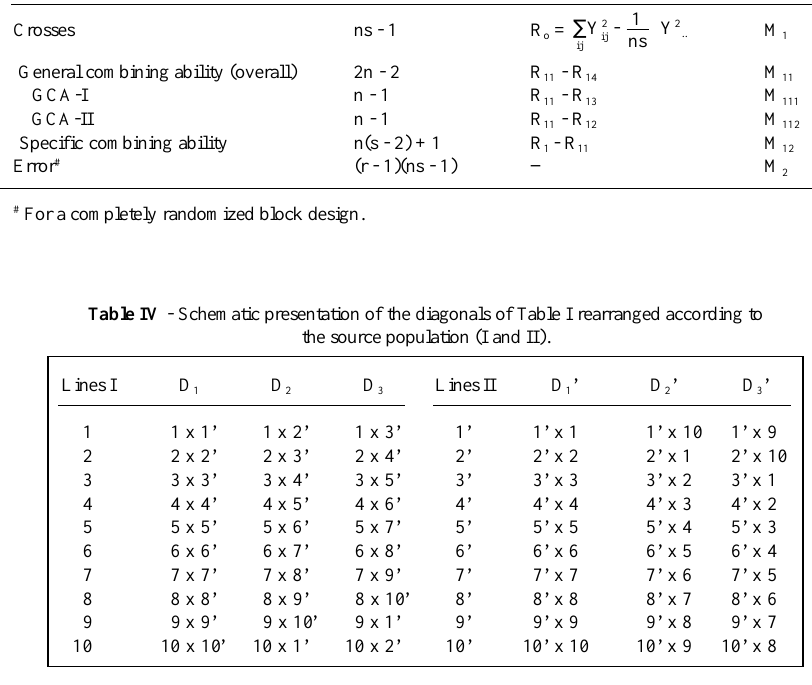
Table III - Analysis of variance for crosses in the partial circulant diallel scheme at the interpopulation level. Source Mean squares Crosses General combining ability (overall)